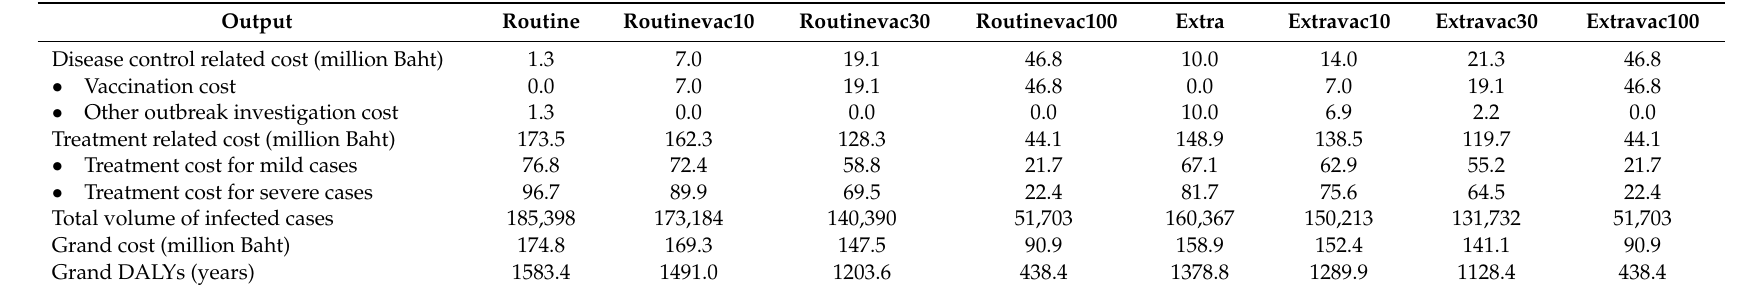
Table 5. Overall results in each interested